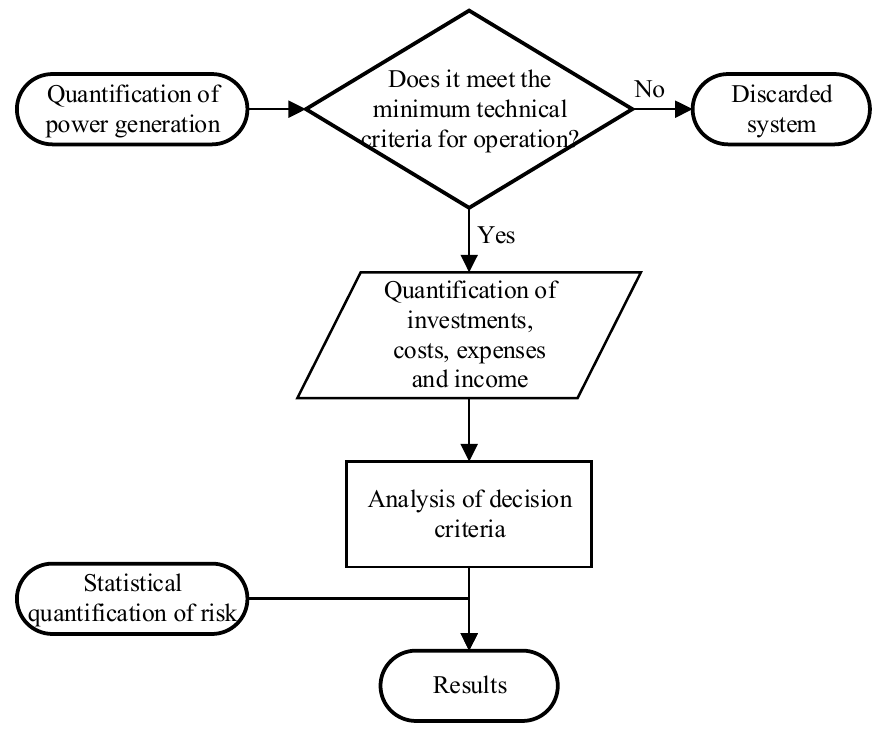
Figure 3. Stages of the economic feasibility study of the system. Operating and maintenance costs for gasification systems (not including the fuels) range from 3.5% to 5.7% of their capital expenditure (CAPEX), according to [15]. In this study, the mean value of the range (4.60%) was taken as a starting parameter. The risk study incorporated the lower and upper limits through a triangular distribution.